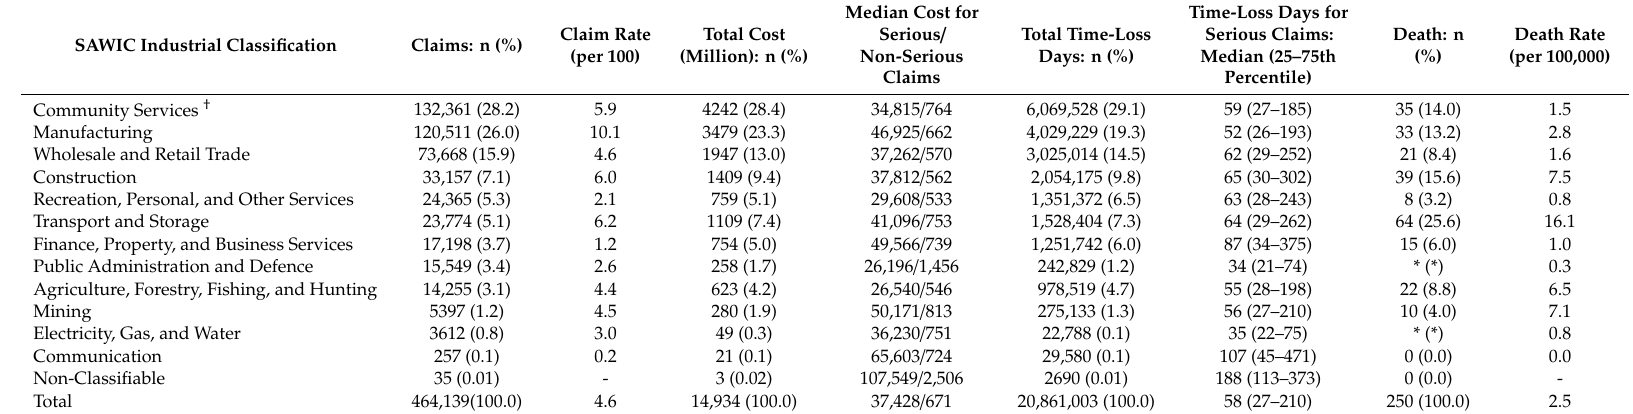
Table 1. The number of claims, percentage, compensation payment, time-loss days, and deaths by industry, South Australia, 2000–2014.